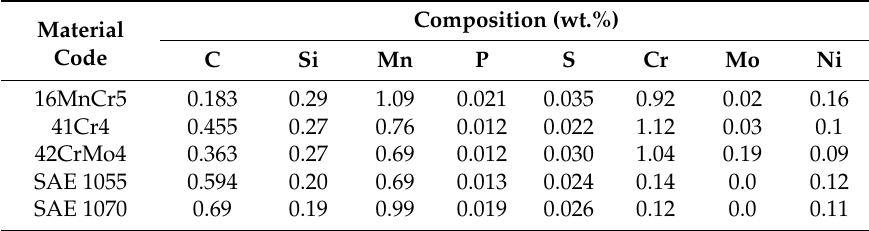
Table 1. The corresponding chemical composition of the different material codes. Material Code